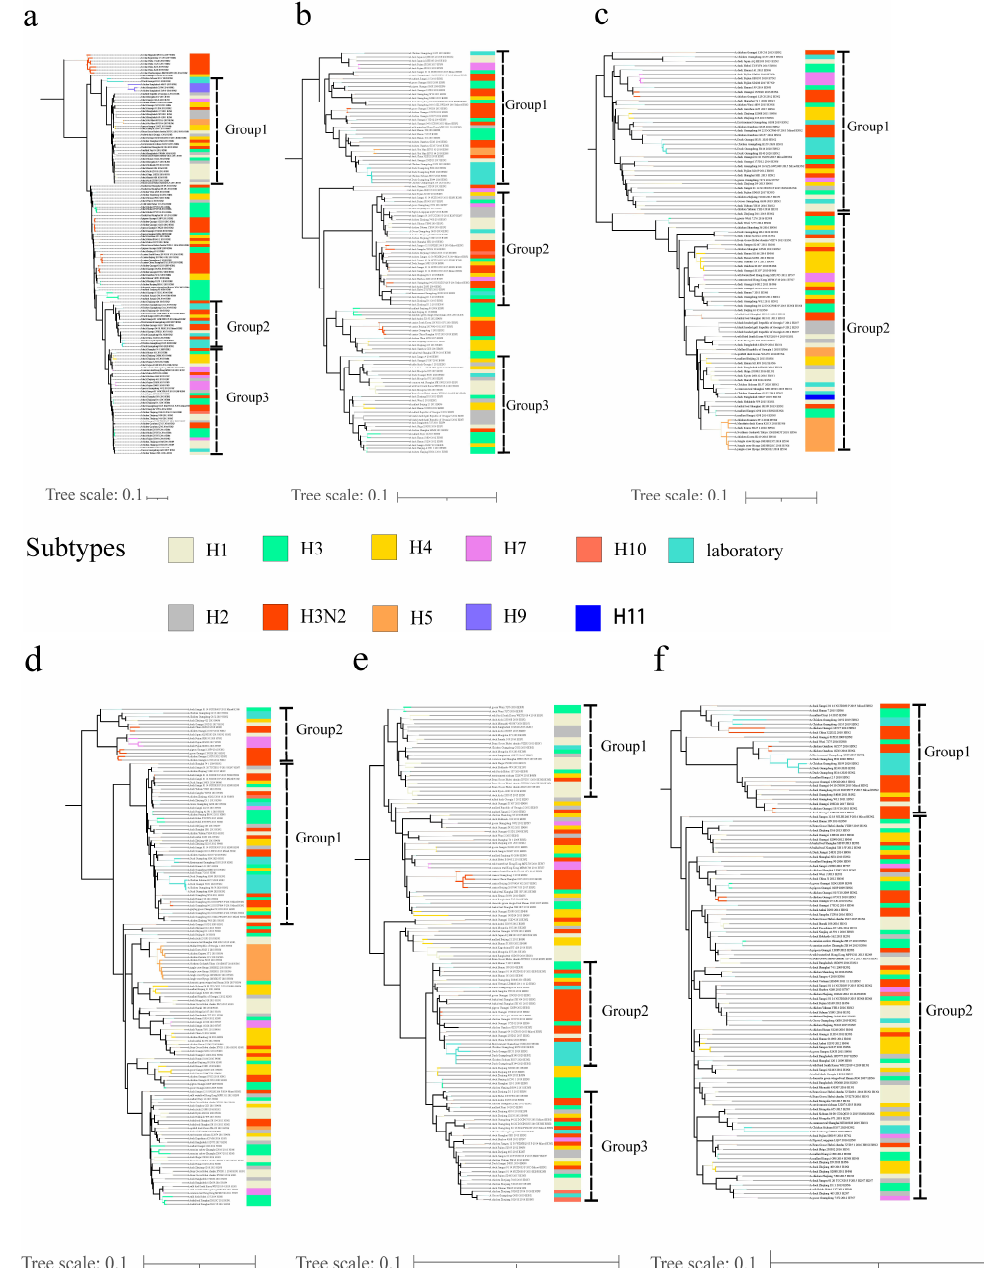
Figure 2. Phylogenetic analysis of internal genes of H3N2-subtype AIVs isolated from 2019 to 2020 3 using the maximum likelihood method. The phylogenetic trees of PB2 ( a ), PB1 ( b ), PA ( c ), NP ( d ), MP ( e ) and NS ( f ) were obtained as a midpoint-root tree. Phylogenetic analysis was performed three times using the maximum likelihood (ML) method in IQ-TREE under the GTR + F + G4 model with 5000 bootstrap replications. Reference sequences were downloaded from the available databases. The turquoise color represents the isolates in this study. Light yellow2, gray, orange red 1, med spring green, gold, tan 1, violet, slate blue 1, coral 1 and snow 1 represent H1, H2, H3N2, H3, H4, H5, H7, H9, H10, and H11,